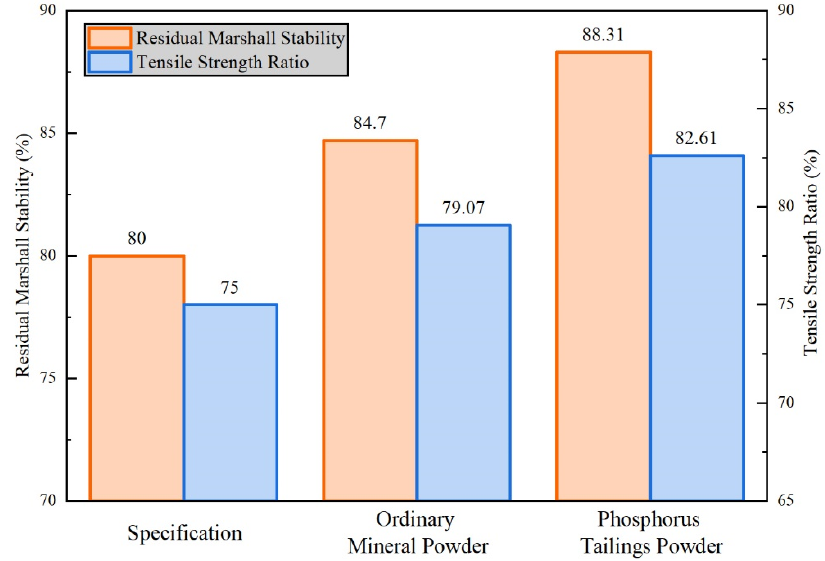
Figure 11. Comparison of moisture damage resistance of two asphalt